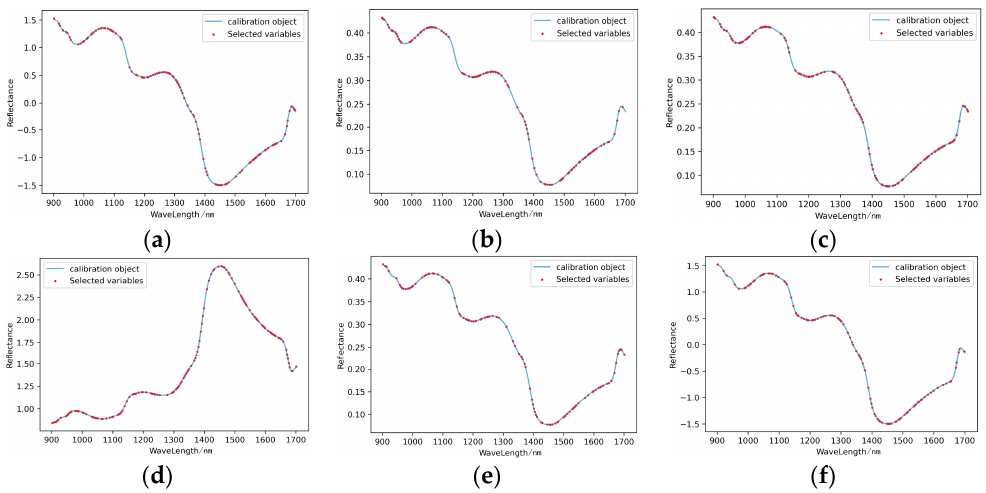
Figure 12. Characteristic wavelengths’ distribution of prediction models for the content of calcium in pear peel. ( a ) SNV-GA-PLSR; ( b ) MSC-GA-PLSR; ( c ) SG-GA-PLSR; ( d ) LG-GA-PLSR; ( e ) SG+MSC-GA-PLSR; ( f ) SG+SNV-GA-PLSR.